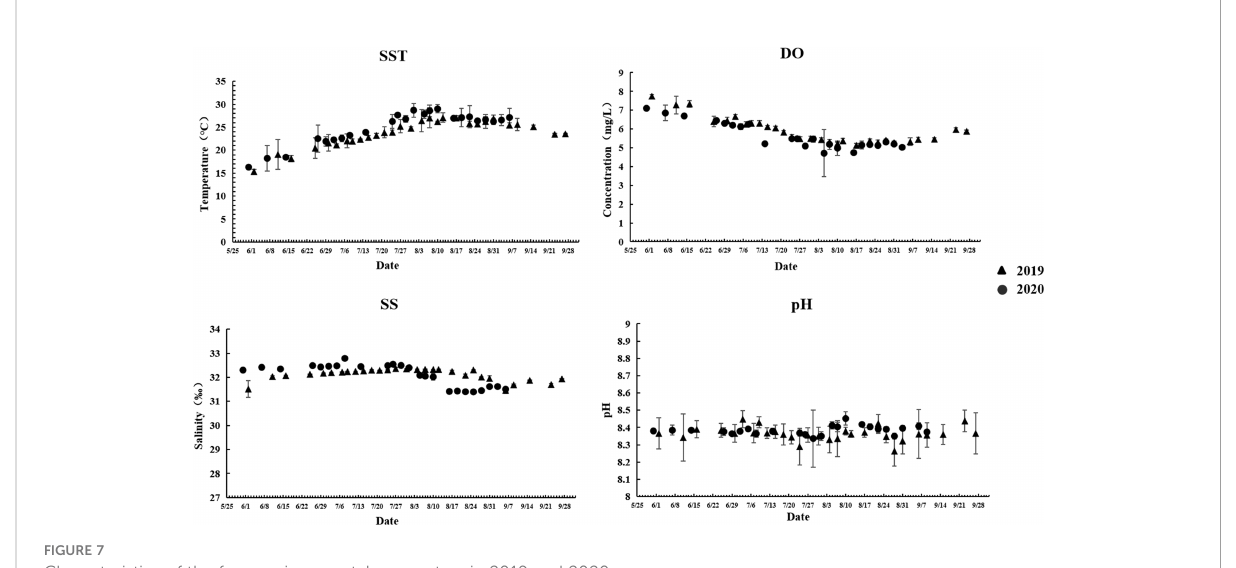
FIGURE 7 Characteristics of the four environmental parameters in 2019 and